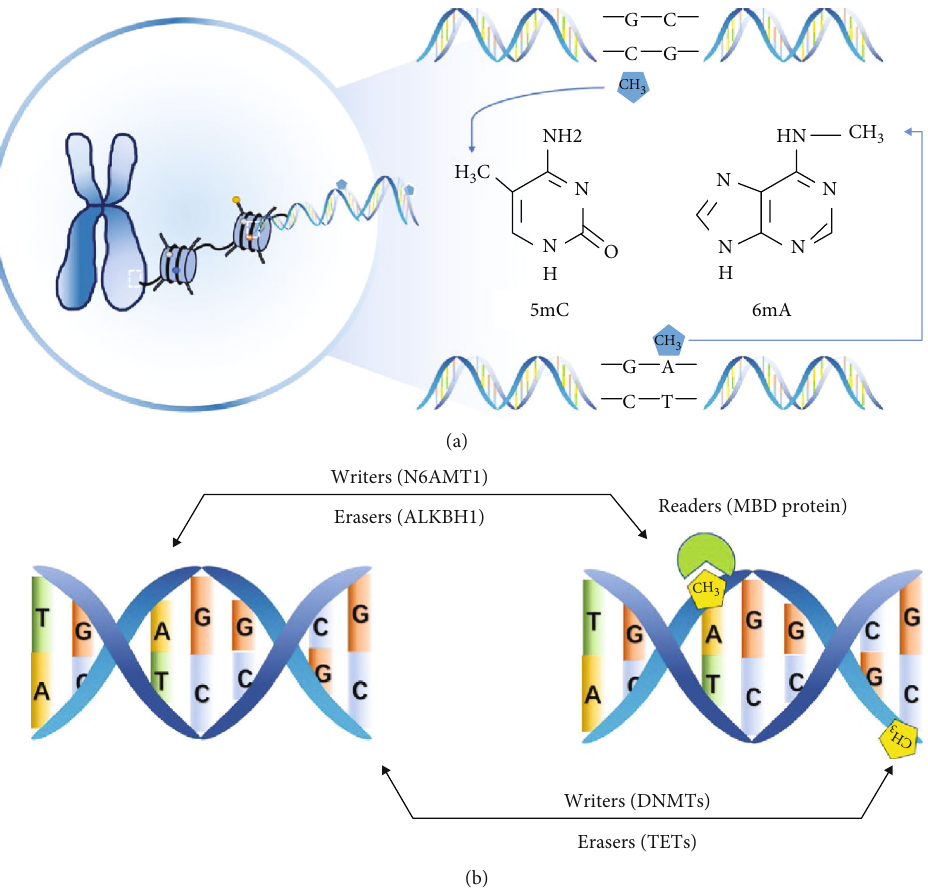
Figure 1: Modulation of DNA methylation in mammals. (a) DNA 5mC methylated site is the fi fth position of cytosine, while 6mA modi fi cation occurs at the sixth position of adenine in DNA. (b) Methylation marks are established by writers, such as DNMTs and N6AMT1. These modi fi cations are identi fi ed by readers, like methyl-CpG-binding domain (MBD) proteins. Erasers, among which TETs and ALKBH1 are representatives, can make all the marks invalid by oxidizing or removing methyl Table 1: Enzymes involved in mammalian DNA methylation.